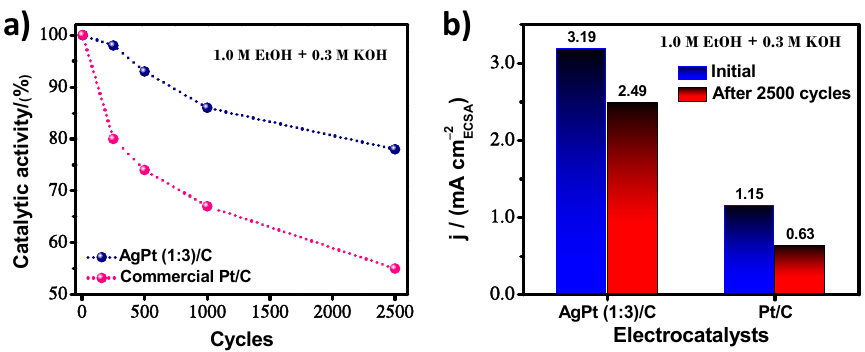
Figure 8. ( a ) Evaluation of the percentage of catalytic activity as a function of the number of cycles